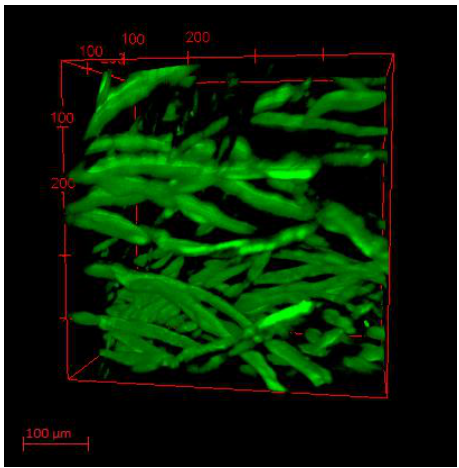
Figure 2. Tomography image of cotton textile (350 µm depth) made by 2p-fluorescence microscope.